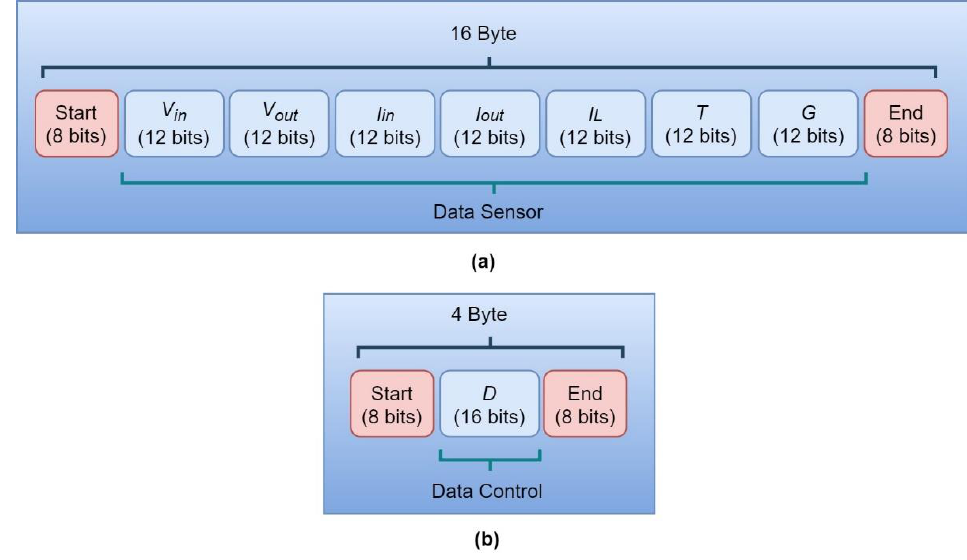
Figure 9. Serial frame structure and field size: ( a ) sending from the dsPIC to the PC; ( b ) sending of the control signals from the PC to the dsPIC.